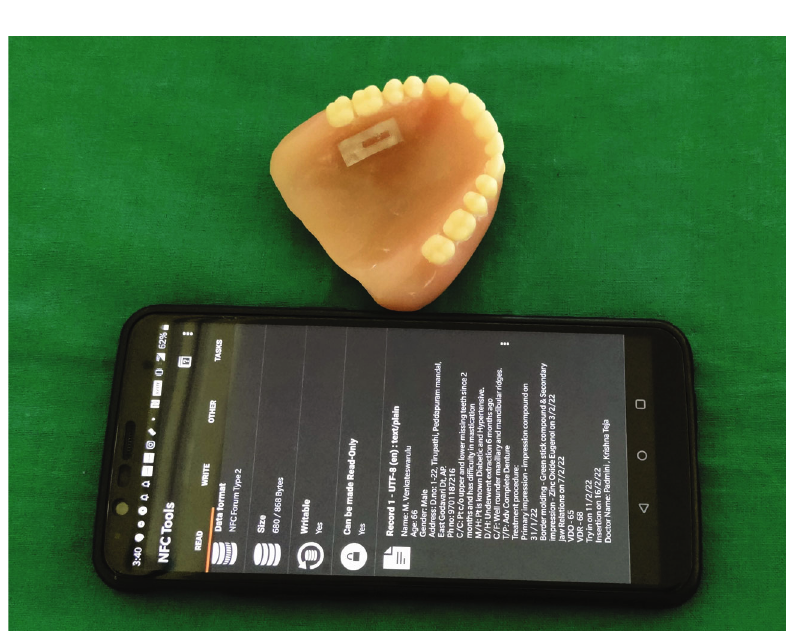
Figure 9: Secured patient information in NFC